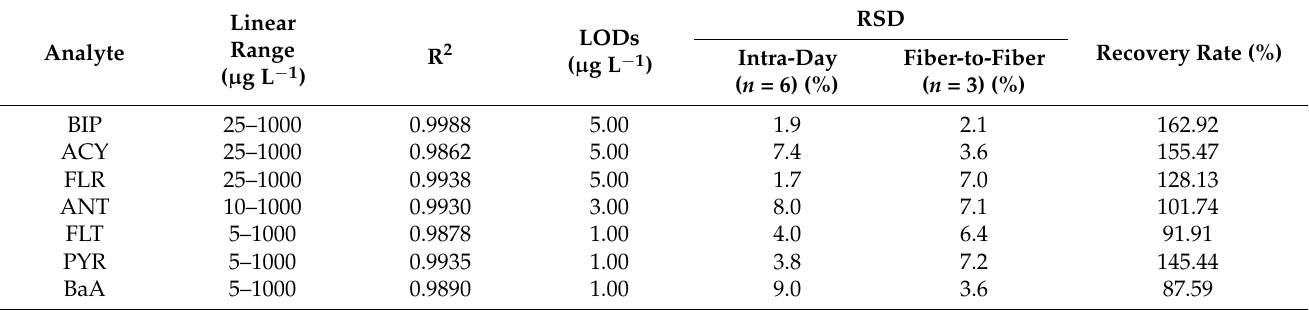
Figure 7. The chromatogram of seven kinds of PAHs in optimized conditions. Table 1. Analytical performance of the COF-TpBD-bonded AN-SSF for the SPME of PAHs.